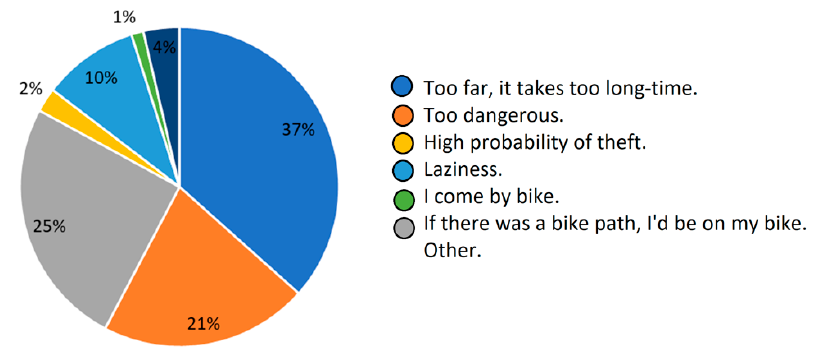
Figure 5. Answers to the question “Why do not you come to university by bike?”.